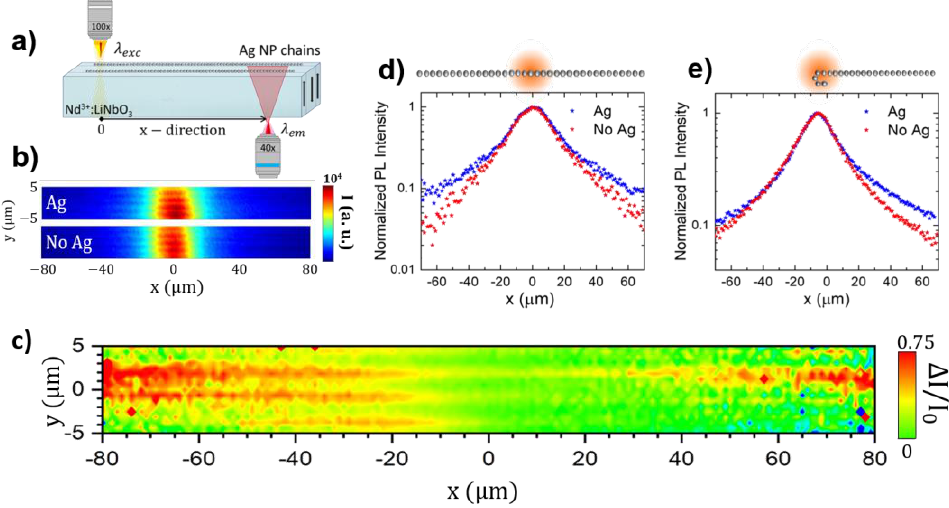
Figure 2. ( a ) Schematics of the experimental set-up. ( b ) Nd 3+ PL spatial maps obtained after integrating the 4 F 3/2 → 4 I 9/2 emission (centered at around 900 nm) when exciting on top of a plasmonic chain (Ag) and on the bare surface of the substrate (No Ag). ( c ) Differential emission map obtained from the images displayed in panel ( b ). ( d ) Normalized PL intensity profiles extracted from the Ag and No Ag images along the X direction, where the plasmonic chain is located. The excitation is focused on x = 0 μm. ( e ) Normalized PL intensity profiles obtained for a bended plasmonic chain.